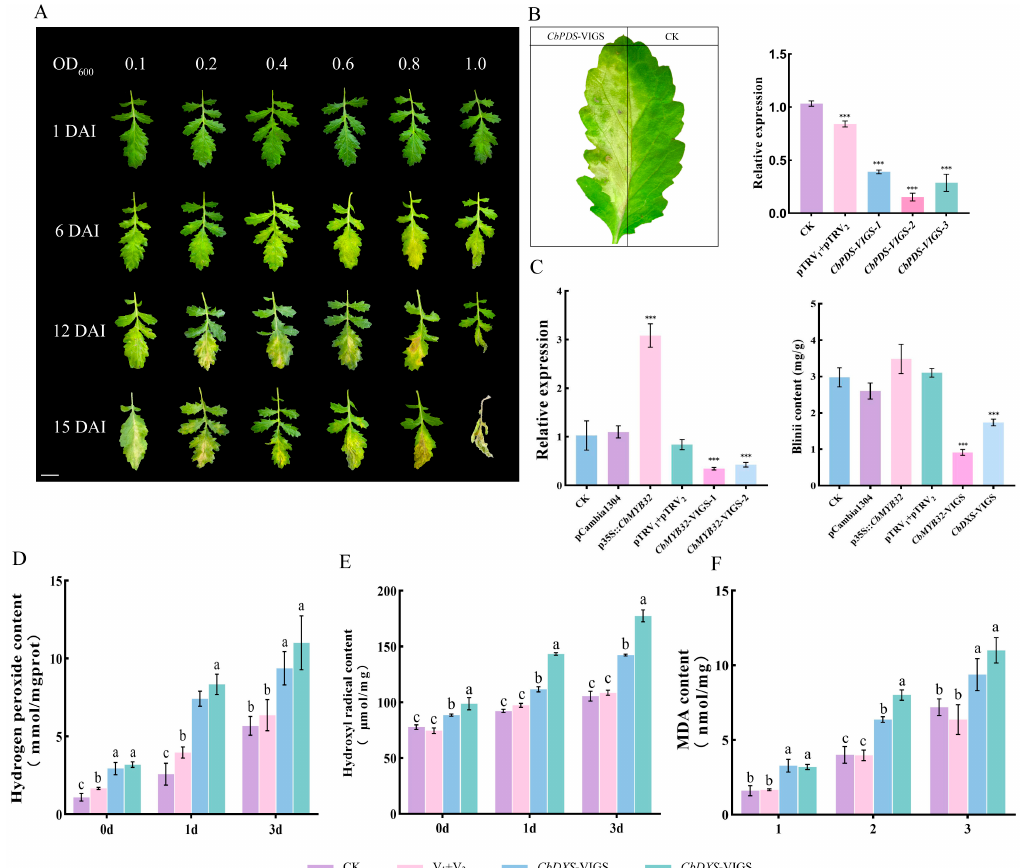
Figure 5. Agrobacterium-mediated transient transformation of C. blinii . Development of CbPDS transgenic leaves. DAI: days after infected. Leaves will bleach when the CbPDS is silenced. Bar = 1 cm. ( A ). CbPDS -VIGS leaf phenotype. Three samples were randomly selected to detect changes in expression after CbPDS was silenced. The pTRV 1 + pTRV 2 group indicating the empty vector control ( B ). The relative expression of CbMYB32 treated with OE (overexpression) and VIGS under NLT for 3 days. Changes of blinin content after OE and VIGS under NLT for 3 days. The pCambia1300 indicating the empty vector control ( C ). Determination of hydrogen peroxide content under NLT ( D ). Determination of hydroxyl radical content under NLT ( E ). Determination of Malondialdehyde (MAD) content under NLT ( F ). Three independent biological repeats were set for each group. Asterisk indicates significant differences between CK and experimental groups at the same time (*** p < 0.05). Different letters indicate significant differences at the p < 0.05 level when comparing different experimental groups according to a one-way